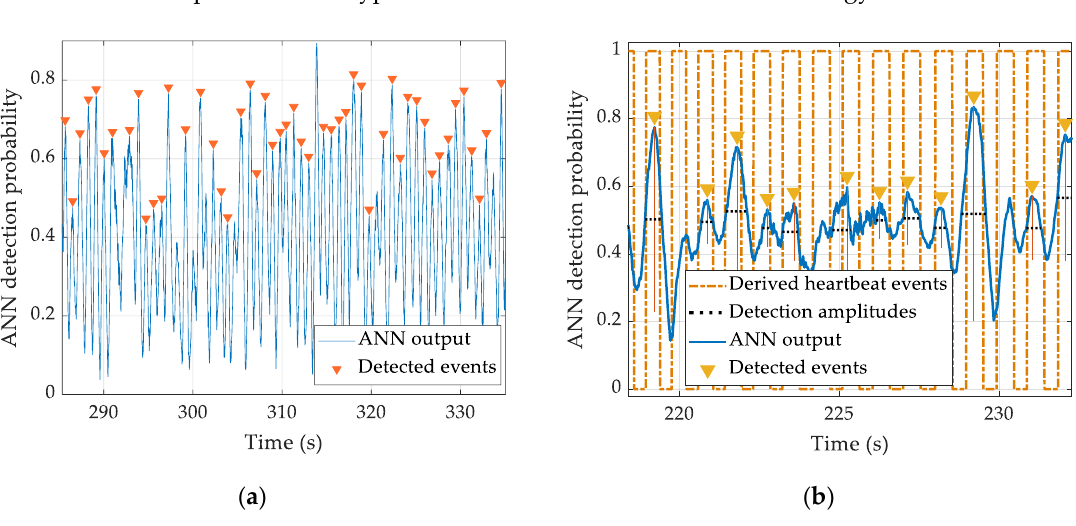
1 Percentage error of the number of the detected heartbeats out of a total 5144 heartbeats. The negative values correspond to fewer detected heartbeats by ANN compared with the “ground truth” ; 2 Inter-pulse interval (IPI) mean relative error; 3 Number of subjects with no significant difference between the medians of the estimated IPI-s and the IPI-s from the ECG reference, out of the total 21 subjects; 4 Feed forward ANN; 5 Nonlinear autoregressive exogenous model; The numbers in the topology descriptions stand for the number of units in each layer.